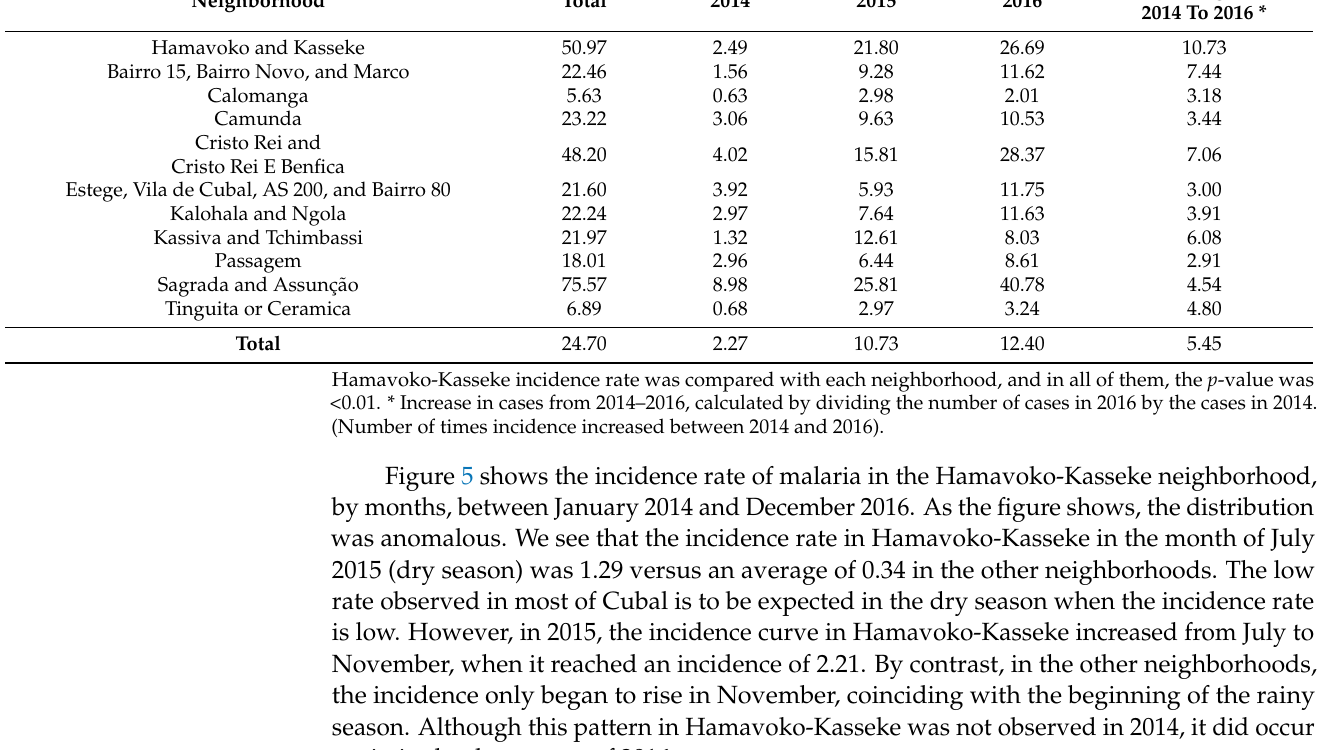
Fold Change From 2014 To 2016 *